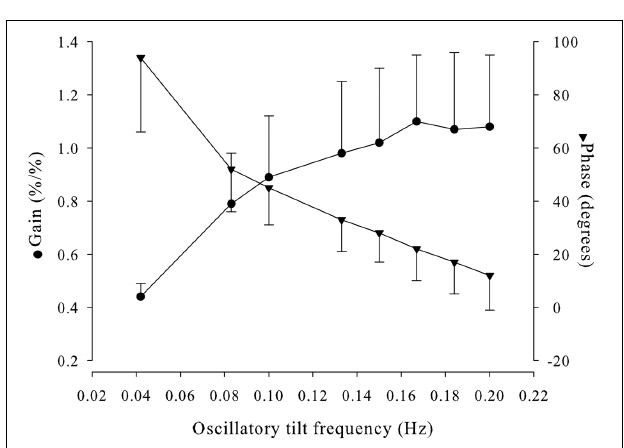
FIGURE 9 | MCAV mean -MAP transfer function displayed by gain and phase for each oscillatory tilt frequency. MCAV mean , mean middle cerebral artery flow velocity; MAP, mean arterial